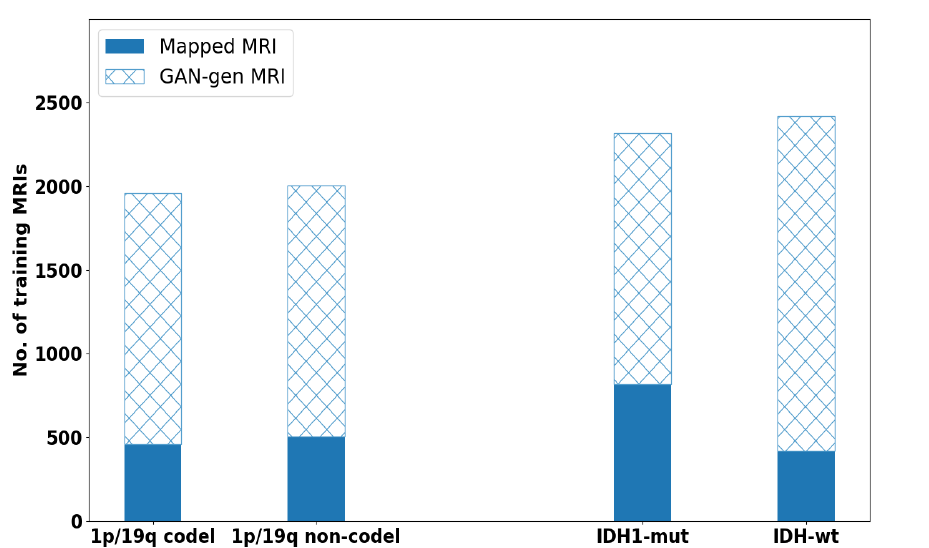
Figure 8. Total number of data (GAN augmented + Mapped MRI) for one modality of training set, i.e., 60% in both case studies.